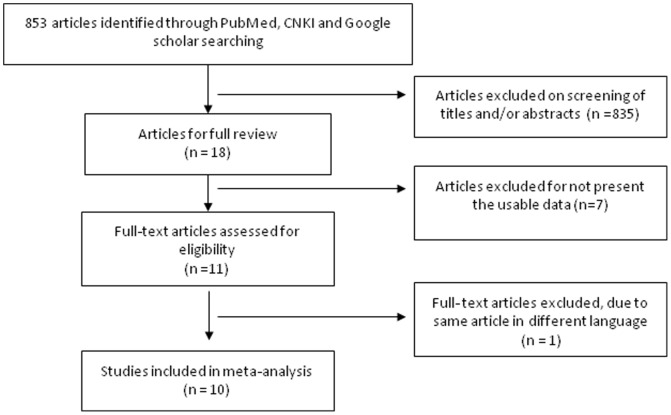
Schematic flow diagram for selection of included studies.